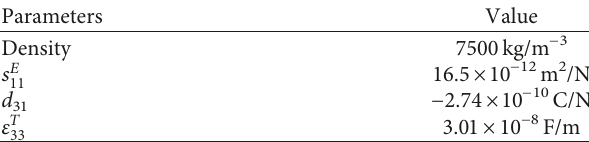
Table 1: Material parameters of PZT-5H.